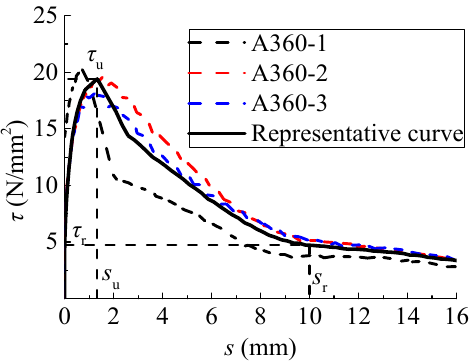
Figure 10. Typical experimental and representative bond–slip curves.